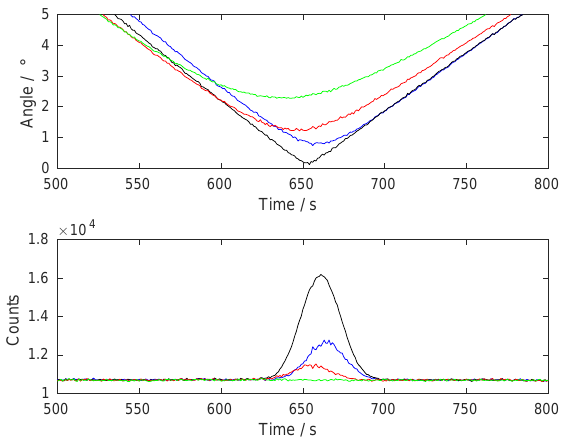
Figure 2. Moon intrusion event in different deep-space views on 30 October 2015, with MHS on MetOp-A; blue: DSV 1; black: DSV 2; red: DSV 3; green: DSV 4. Top: angle between Moon and space view. Bottom: space view